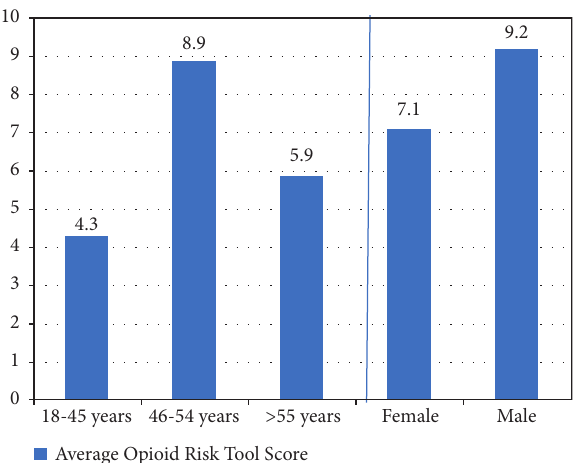
Figure 2: The average Opioid Risk Tool score by age and